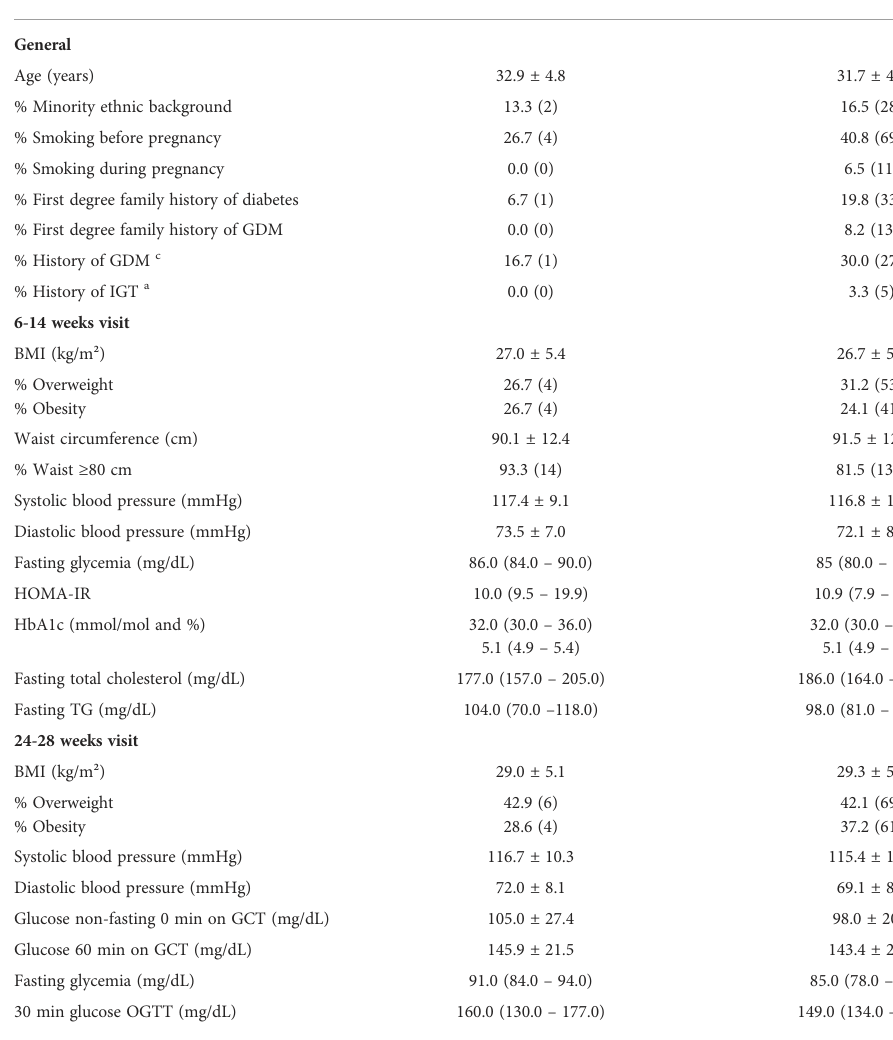
TABLE 2 Comparison of characteristics and pregnancy outcomes between GDM with autoantibodies (group 1), GDM without autoantibodies (group 2) and NGT women (group 3). GDM with autoantibodies N=15